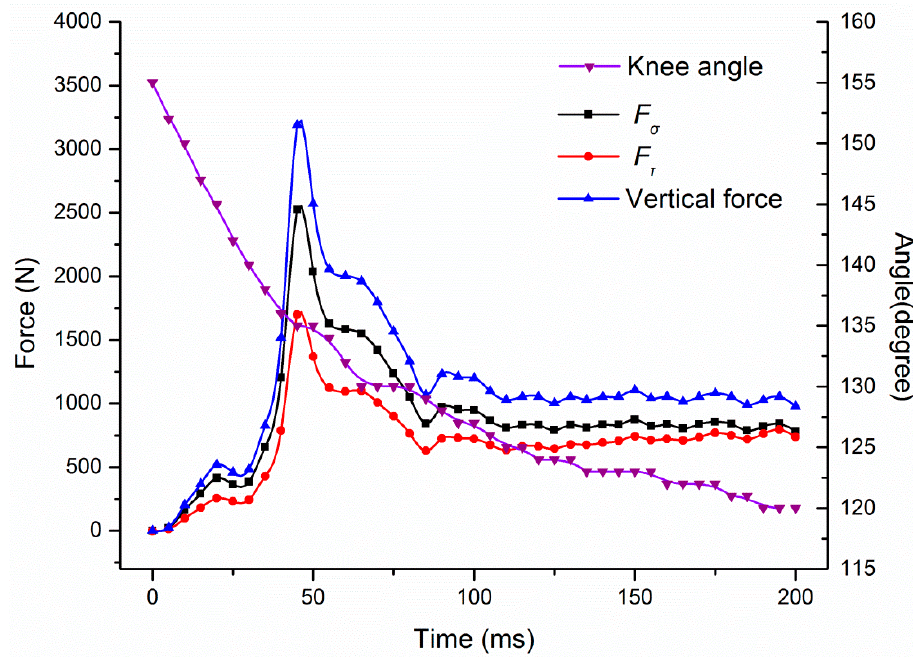
Figure 6. Force curve of a single knee joint in the balancing phase.